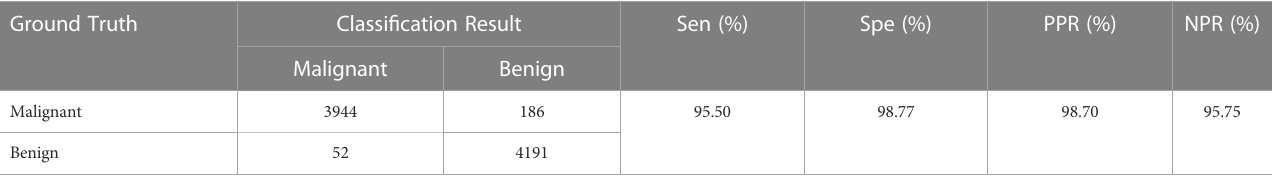
(d, n) represent the depth and number of decision tree, respectively. The bold values represent optimized parameters and TABLE 7 Confusion matrix of binary classi fi cation results and values of evaluation metrics.. Sen, sensitivity; Spe, speci fi city; PPR, positive prediction rate; NPR, negative prediction rate.